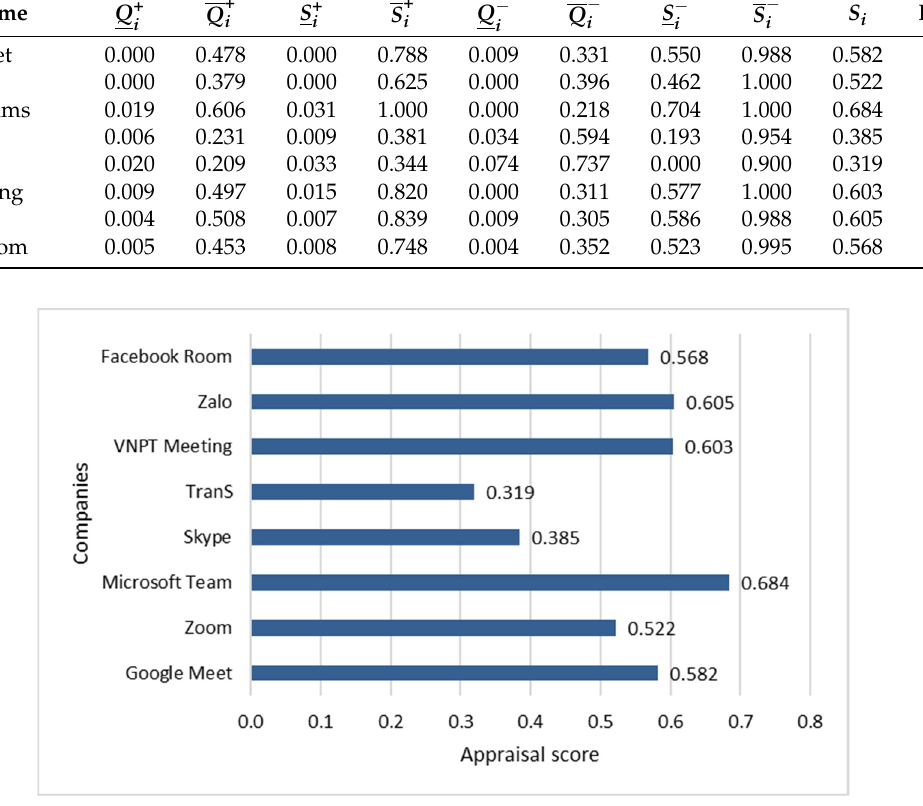
Figure 5. Final alternatives ranking of G-EDAS.